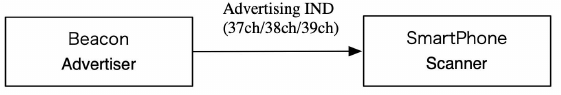
Figure 1. Advertising channels of Bluetooth Low Energy